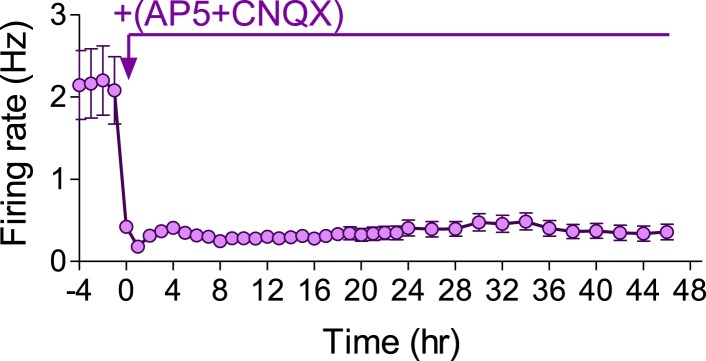
Effect of AMPAR and NMDAR blockers on mean firing rate measured by MEA in hippocampal cultures.Addition of 10 µM CNQX together with 50 µM AP5 reduced mean firing rate by 80%.